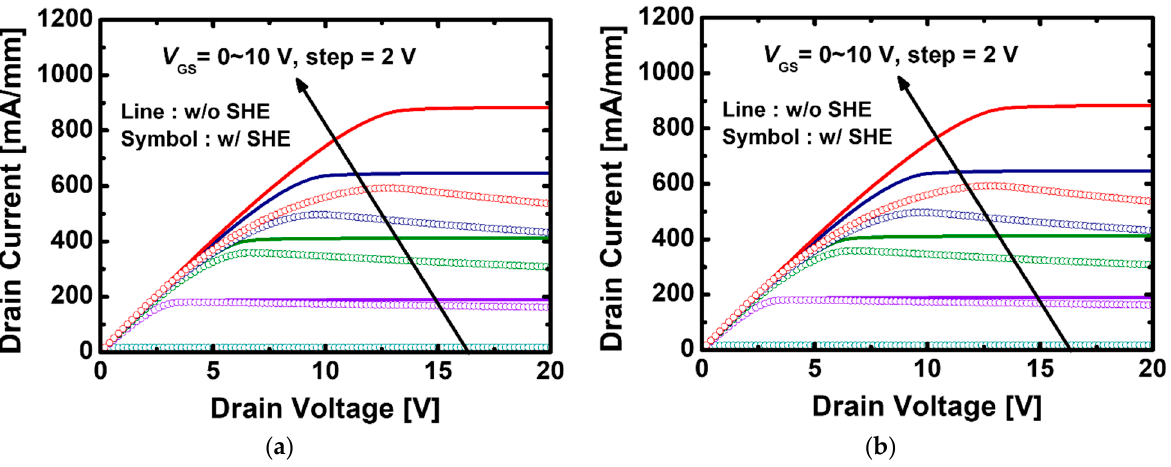
Figure 6. I D - V D transfer characteristics with and without self-heating effect in recessed-gate GaN MOSFET using ( a ) the stacked TiO 2 /Si 3 N 4 dual-layer insulator, ( b ) Si 3 N 4 single-layer insulator.